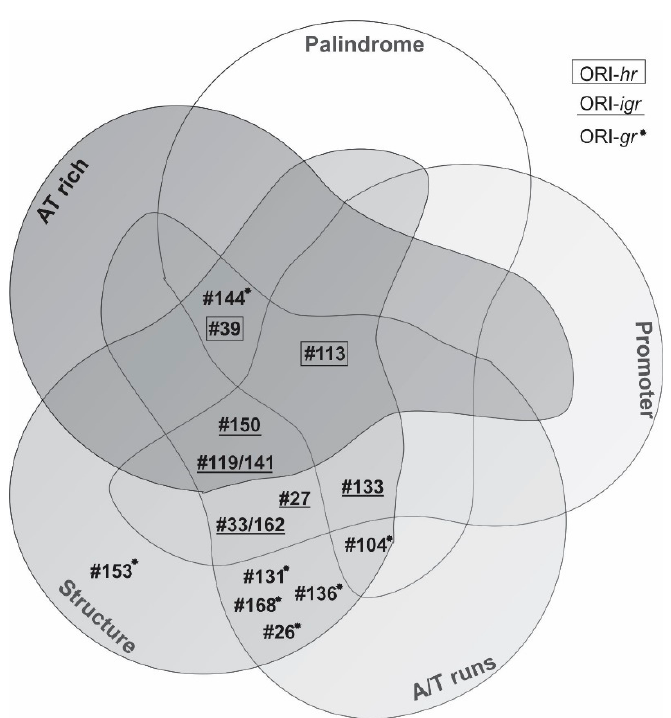
Figure 4. AgMNPV ORI sequences and their shared properties. Venn diagram shows shared properties among di ff erent ORIs of AgMNPV. The AT percentage has been selected only when values were over the average of the AgMNPV genome. Early promoters were considered functional when they are located close to the first ATG codon. In this graphic, only imperfect palindrome > 10 nucleotides were considered.